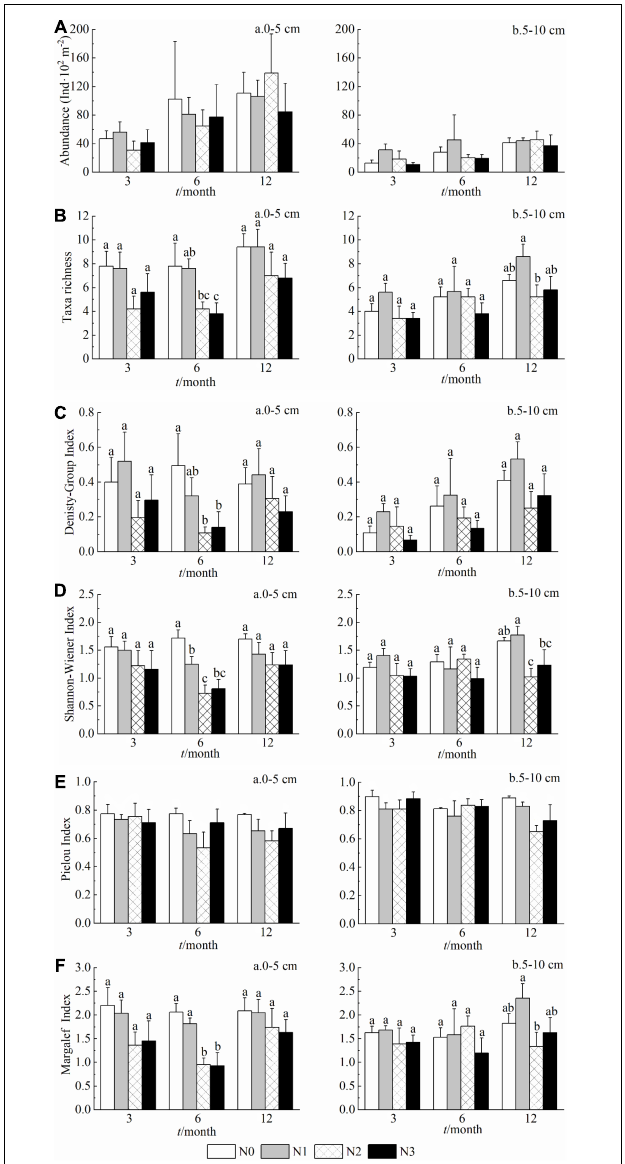
FIGURE 3 | Effects of N addition on the community abundance (A) , taxa richness (B) , and diversity indices (C–F) across sampling dates in 0–5 cm and 5–10 cm layer (a and b, respectively). Data are means ± SE ( n = 5). Results of post hoc tests among treatments are provided with lowercase letters only when the effects of the N treatment in the MANOVA are significant ( p < 0.05) or marginally significant (0.05 < p <